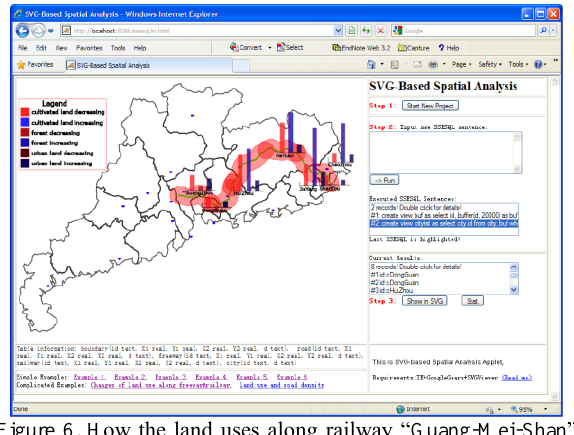
Figure 6. How the land uses along railway “Guang-Mei-Shan” change between 1987 and 1996